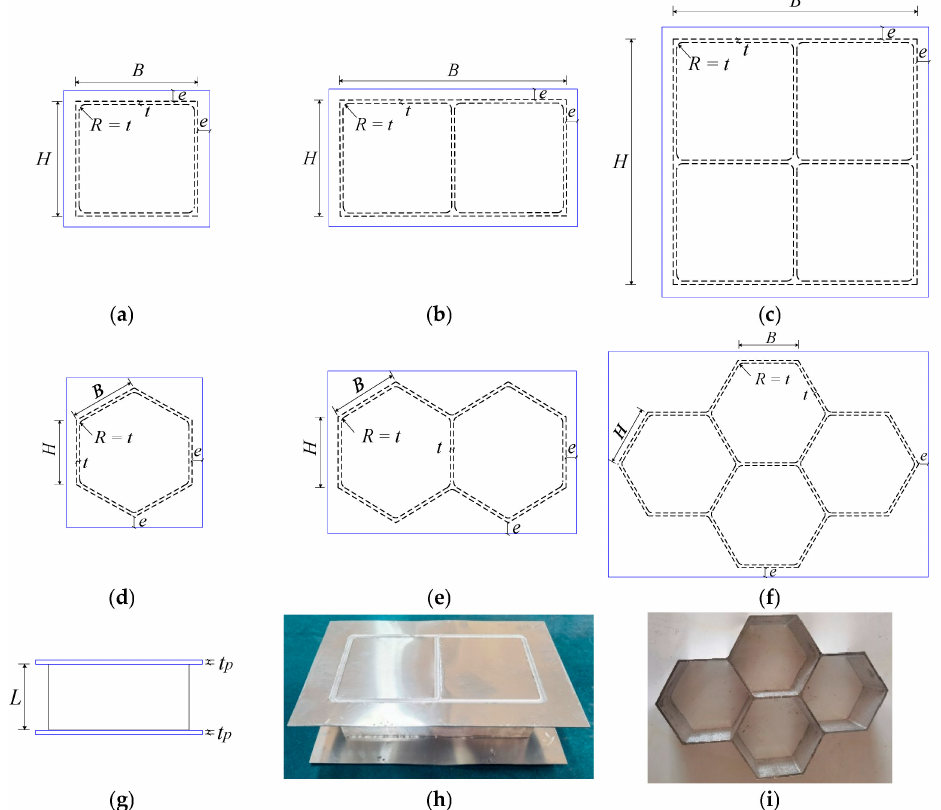
Figure 1. Configurations of honeycomb specimens: ( a ) Single SHS cell with FSW facesheets (top view); ( b ) Double SHS cells with FSW facesheets (top view); ( c ) Four SHS cells with FSW facesheets (top view); ( d ) Single HHS cell with FSW facesheets (top view); ( e ) Double HHS cells with FSW facesheets (top view); ( f ) Four HHS cells with FSW facesheets (top view); ( g ) Elevation view; ( h ) Photo of double SHS cells with FSW facesheets; ( i ) Photo of four HHS cells.